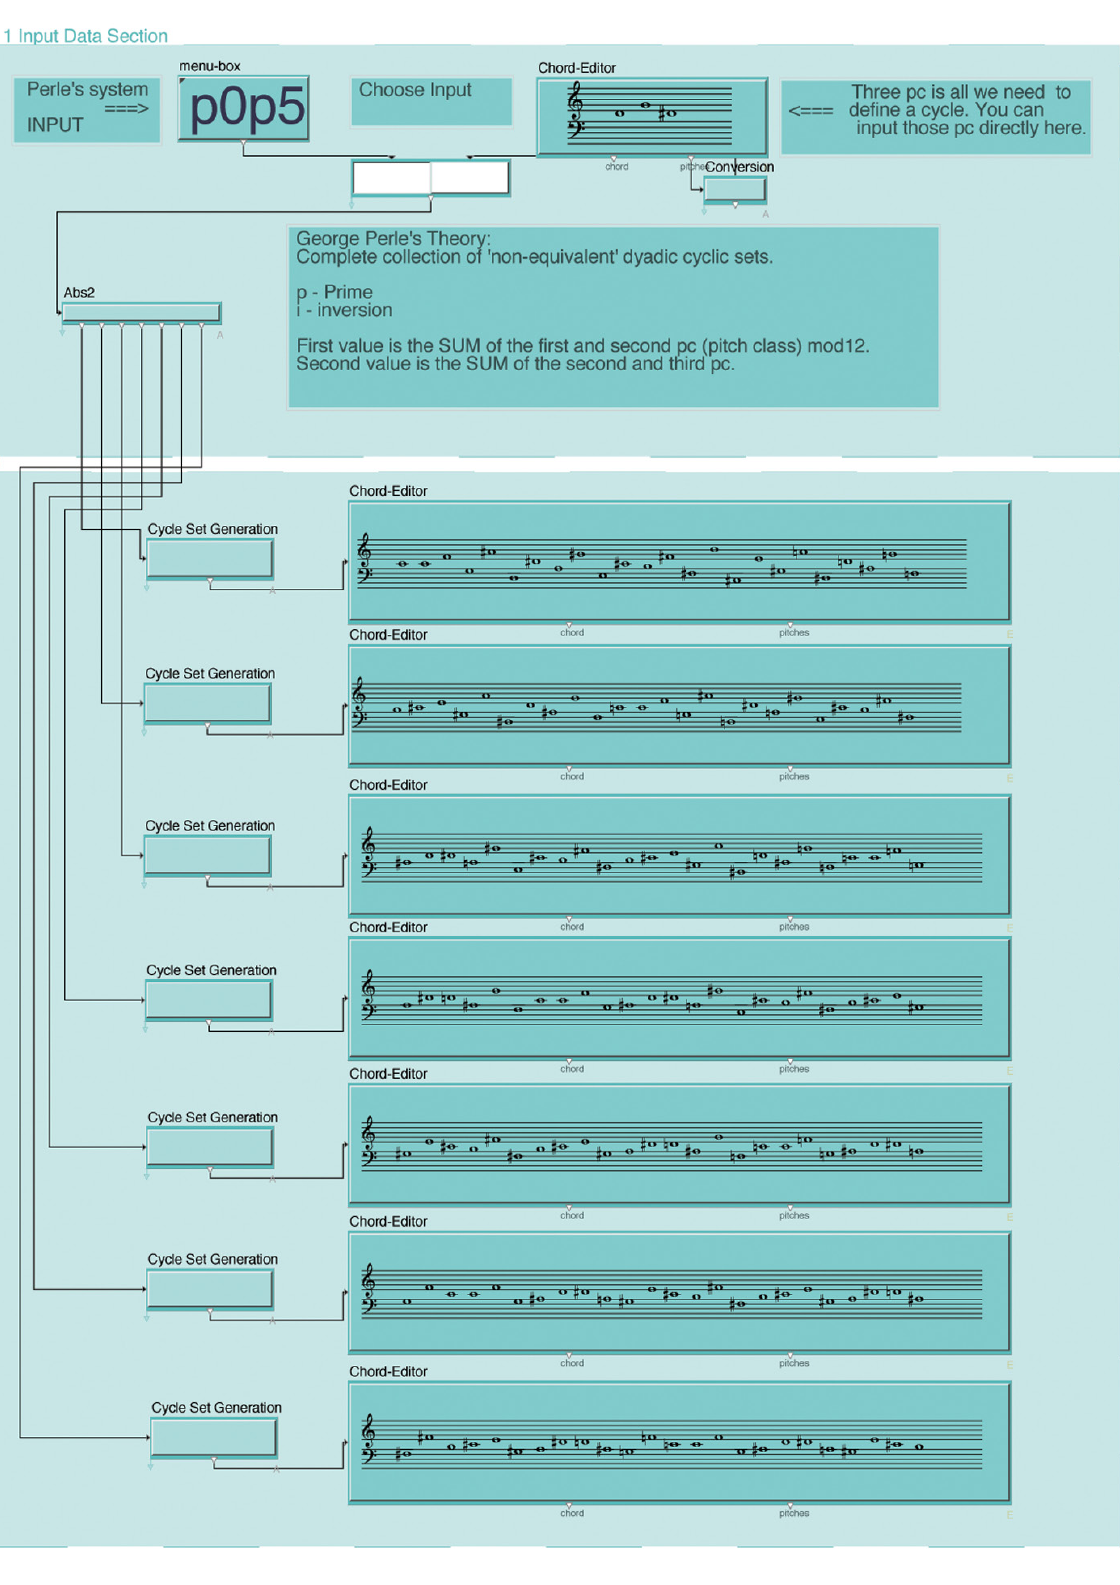
FIGURE 1 | Front Panel of the